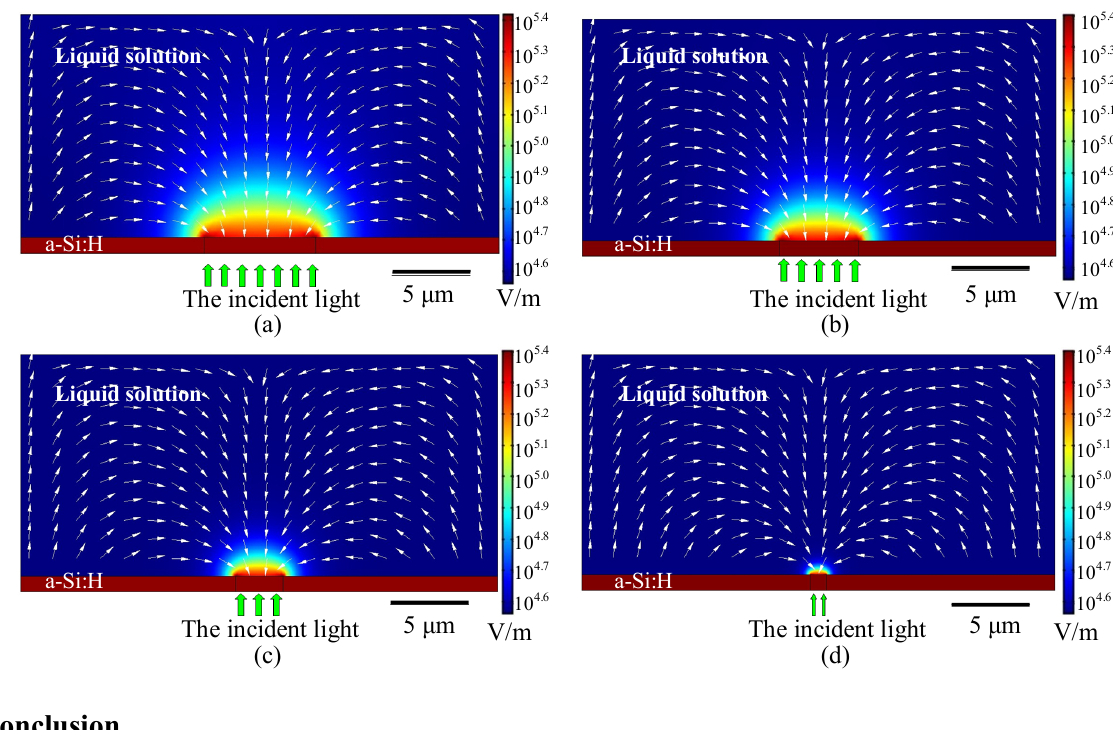
Figure 8. Numerical simulation results showing the dependence of DEP force field as a function of illuminated optical spot size on the bottom substrate of the “ODEP chip”. The diameters of the optical spot sizes shown in (a-d) are 7 μm, 5 μm, 3 μm and 1 μm,